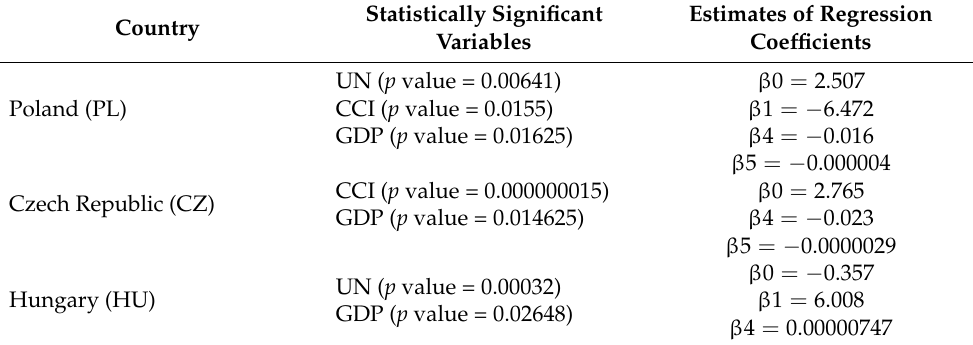
Statistically Significant Variables